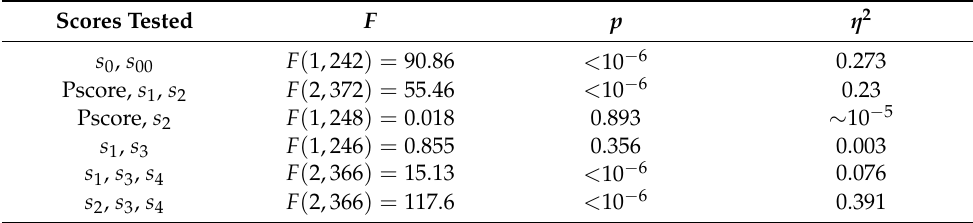
Table 1. Results of one-way ANOVAs to check statistical significance between AUC values on the test set for different groups of scoring functions, with LLPS as positive set and hsnLLPS as negative set. Scores Tested F p η 2